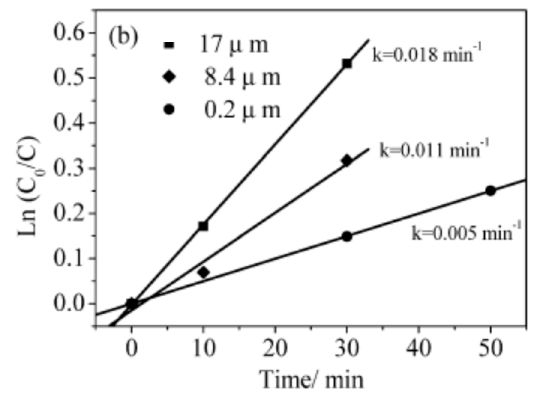
Figure 10. Dependence of ln (C 0 / C) on irradiation time for the photocatalytic degradation of acetaldehyde by TiO 2 nanotube arrays with lengths of 0.2, 8.4 and 17 µ m. Reprinted from [16], Copyright 2020, American Chemical Society.